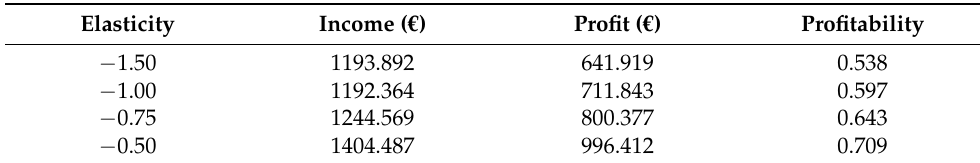
Table 9. Income, profit, and profitability for the various elasticity values.